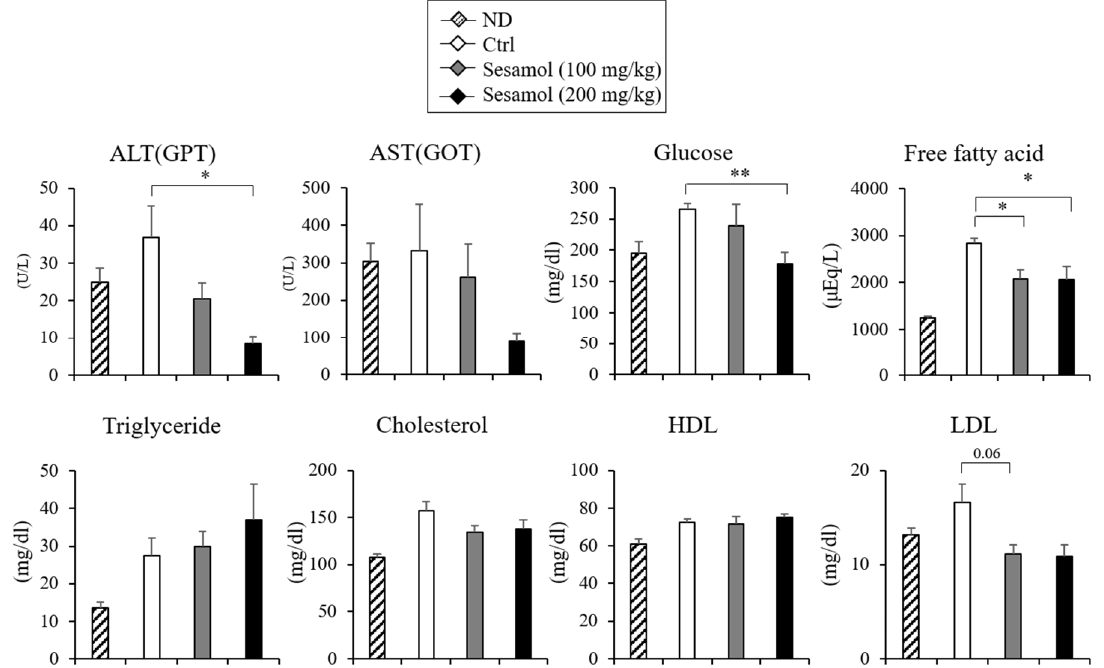
Figure 3. Effects of orally administrated sesamol on serum alanine aminotransferase (ALT; glutamic pyruvic transaminase, GPT), aspartate transaminase (AST; glutamic oxaloacetic transaminase, GOT), glucose and lipid profiles in normal diet (ND)- or high-fat diet (HFD)-fed obese mice. Plasma concentrations of alanine aminotransferase (ALT), aspartate transaminase (AST), glucose, free fatty acids, triglyceride, cholesterol, high-density lipoprotein (HDL), and low-density lipoprotein (LDL) in C57BL/6 mice fed with HFD and administered a daily dose of sesamol at 100 mg/kg or 200 mg/kg ( n = 5 per group). Data represent means ± s.e.m. and statistically significant differences between the control- and sesamol-treated mice were determined by Student’s t-test (* p < 0.05; ** p < 0.005).